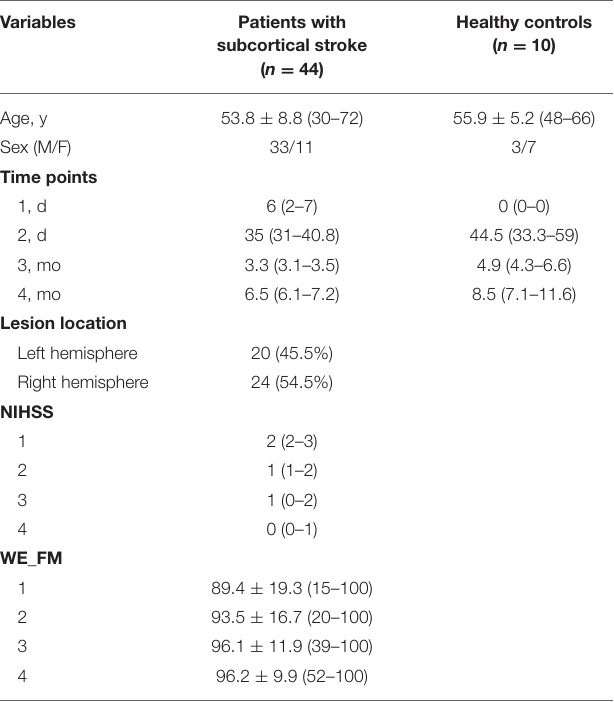
slope ( P = 8.33 × 10 − 9 , Bonferroni’s correction) than the control